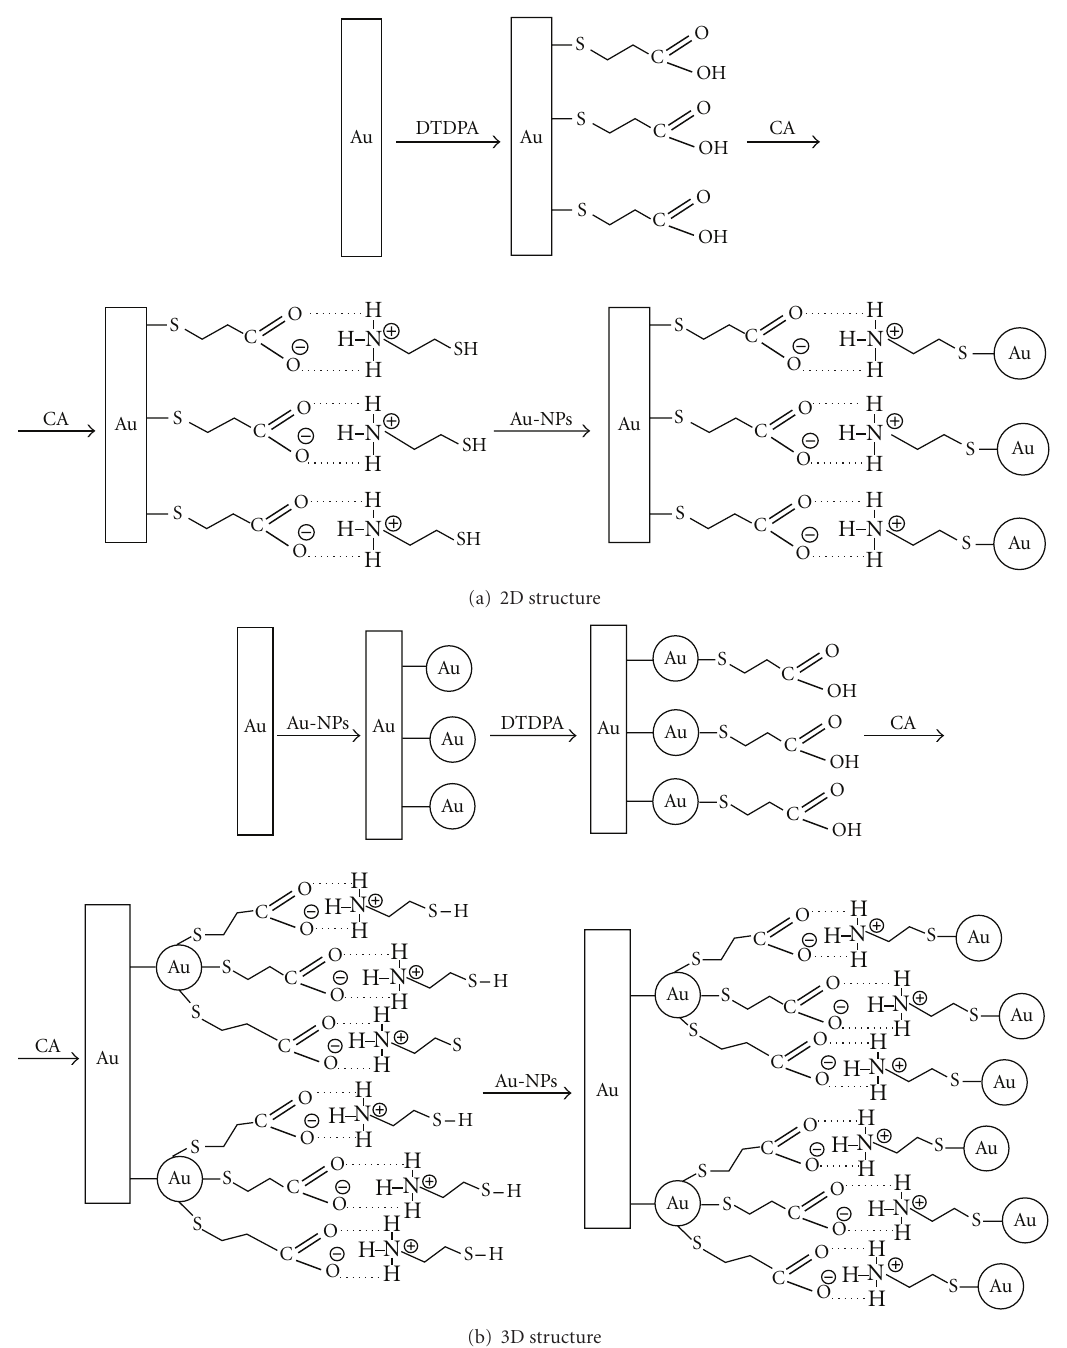
Figure 2: Schematic representation of the surface modifications of the gold electrode for (a) the 2D and (b) 3D gold template.